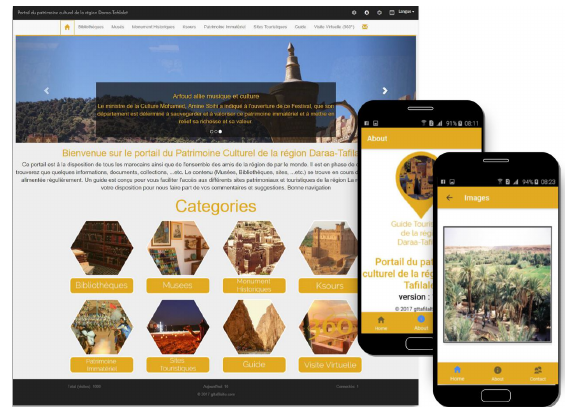
Fig. 4 Web and mobile version of the cultural and natural heritage platform of the Daraˆa-Tafilalet